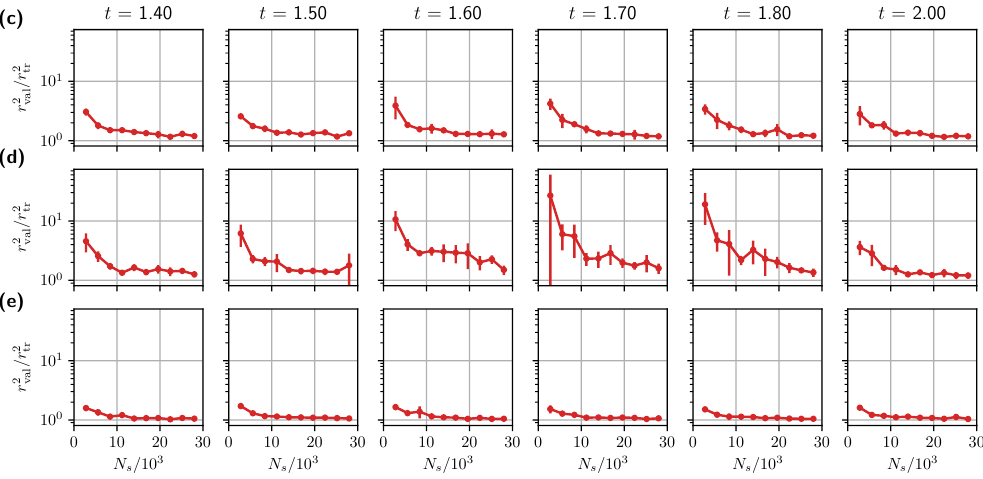
Figure 15: Validation error relative to the TDVP error for the data shown in Fig.